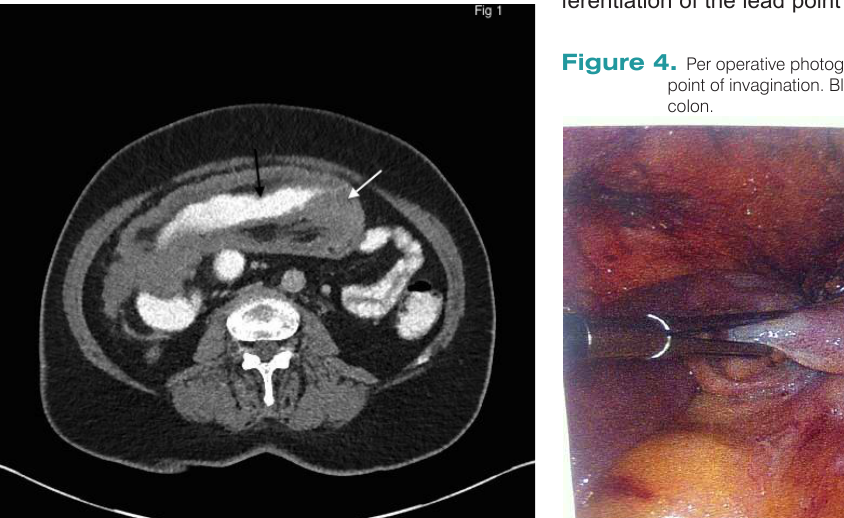
Figure 3. CT scan: Large Bowel Intussusception White arrow showing the lead point (caecal tumour). Black arrow show- ing intussuscepting colon.